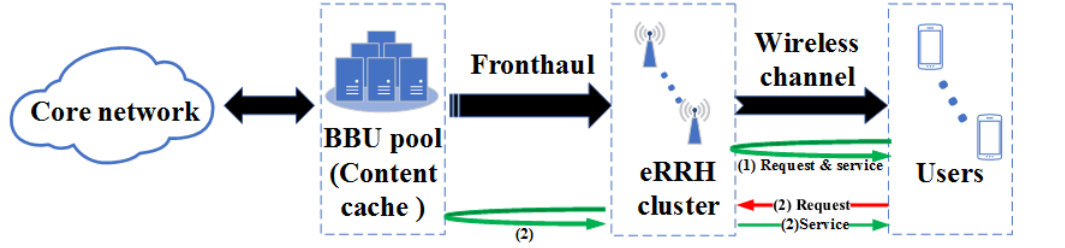
Figure 2. Queueing model of content object transmission with one eRRH-cluster content caching in